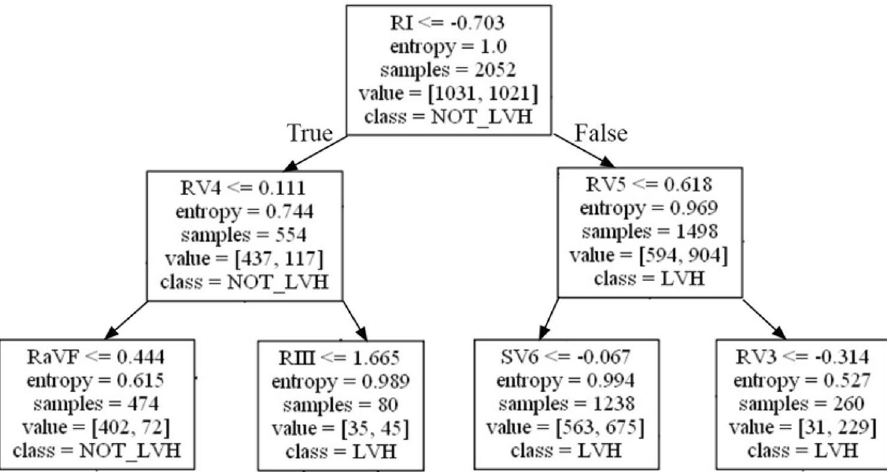
Figure 3. The first three layers of the decision tree after ECG beat